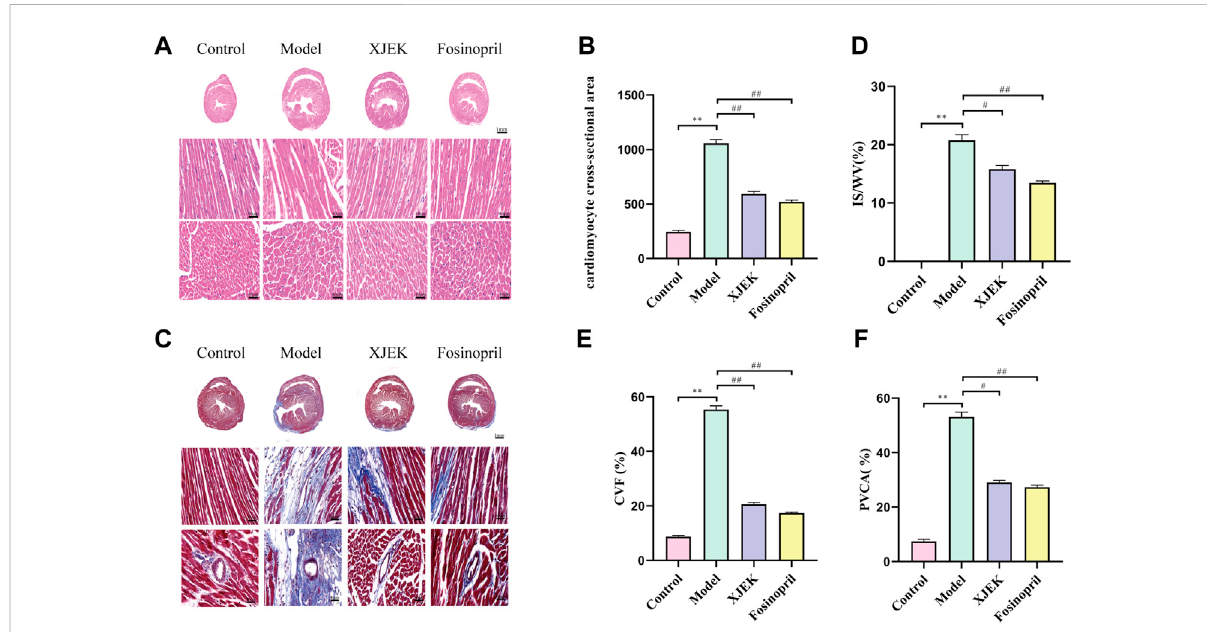
FIGURE 3 XJEK reduced MIR-induced cardiomyocyte hypertrophy and collagen deposition. (A) Representative images of myocardial slices with H&E staining. (B) Quantitative analyses of cardiomyocyte cross-section area. (C) Representative images of cardiac Masson-trichrome staining, with blue staining indicates infract area. Quantitative analyses of the scar size (D) , CVF (E) and PVCA (F) were presented. pp p < 0.01 versus control group, ## p < 0.01 versus MIR model group. Data were expressed as mean ± SD ( n = 6 mice for each